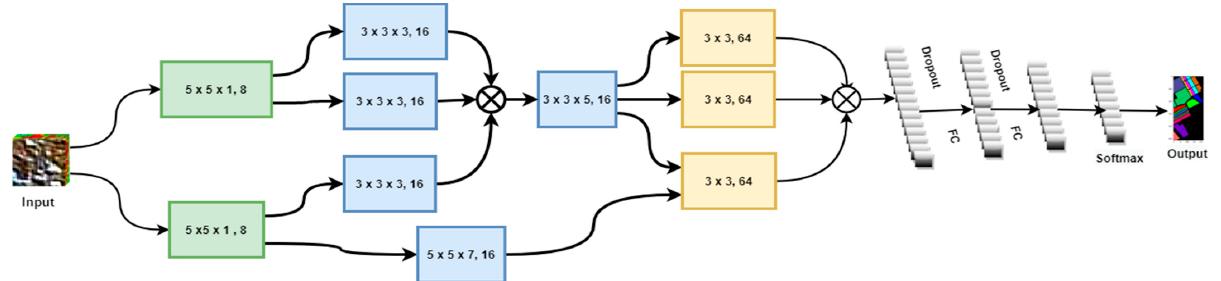
Figure 3. The architectural design of the deep genome graph-based network (GGBN) for hyperspectral image classification.